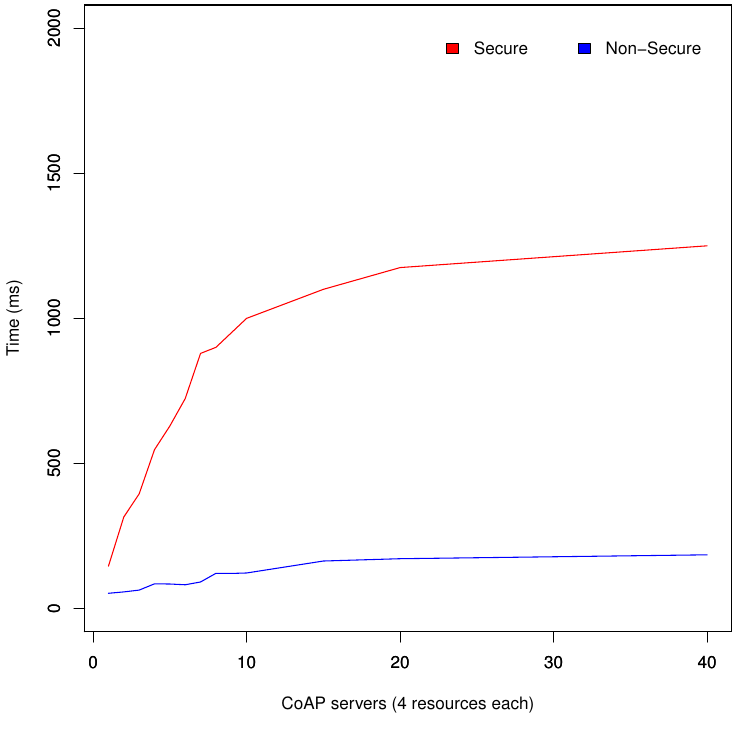
Figure 9. Location discovery response time with respect to the CoAP end points discovered.